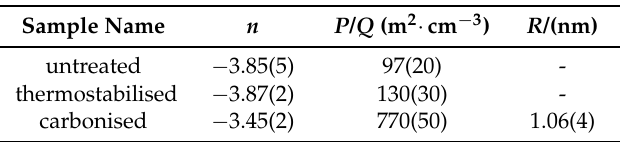
Figure 7. SAXS curves of the untreated, thermostabilised and carbonised organosolv lignin particles. Application of the Guinier evaluation reveals a mean pore radius of R = (1.06 ± 0.04) nm for the carbonised lignin powder, assuming spherical pores. Also the exponent in the Porod regime is less than four, indicating a higher surface roughness. The P / Q ratio representing the total pore surface (open and closed pores) per volume increases slightly from 97 to 130 m 2 ·cm − 3 during thermostabilisation but strongly from 130 to 770 m 2 ·cm − 3 during carbonisation ( cf. Table 1). Table 1. Pore radius of the untreated, thermostabilised and carbonised lignin samples. Errors of the respective fit and calculations, respectively, are given in brackets.